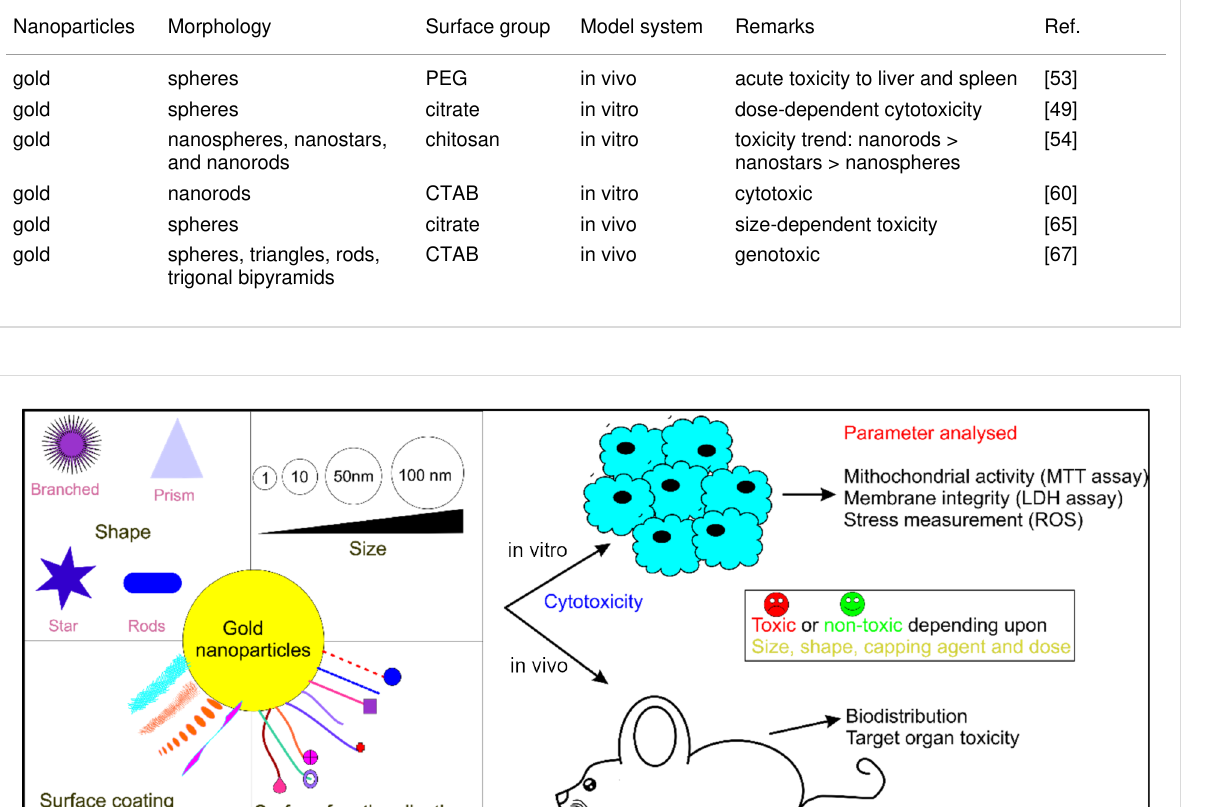
subsequent clinical trials. The physicochemical properties of